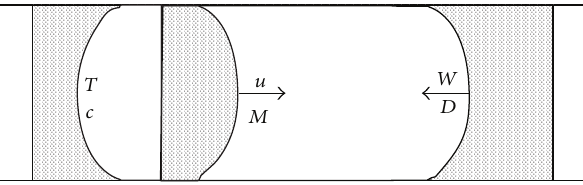
Figure 5: Qualitative profiles of gas-dynamic parameters in a super- sonic flow of